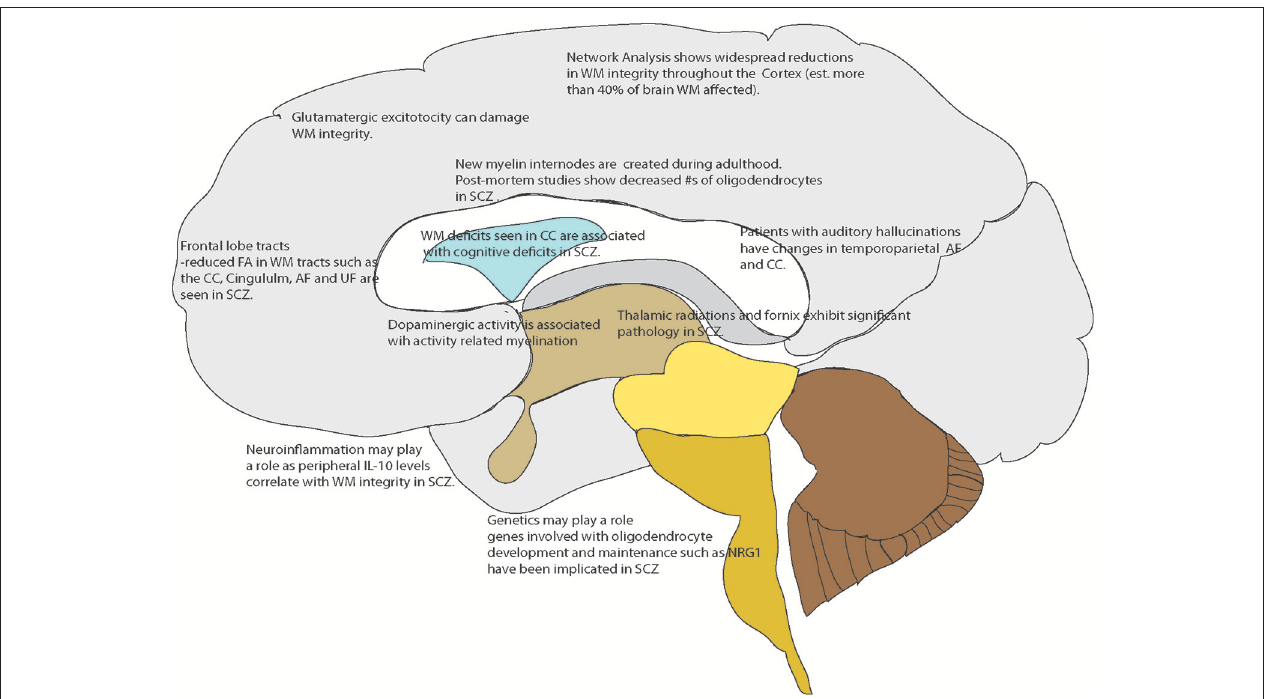
FIGURE 1 | Overview of White matter changes reported in schizophrenia or related to mechanisms known to be affected in schizophrenia that could serve as drug targets. Points referenced in the